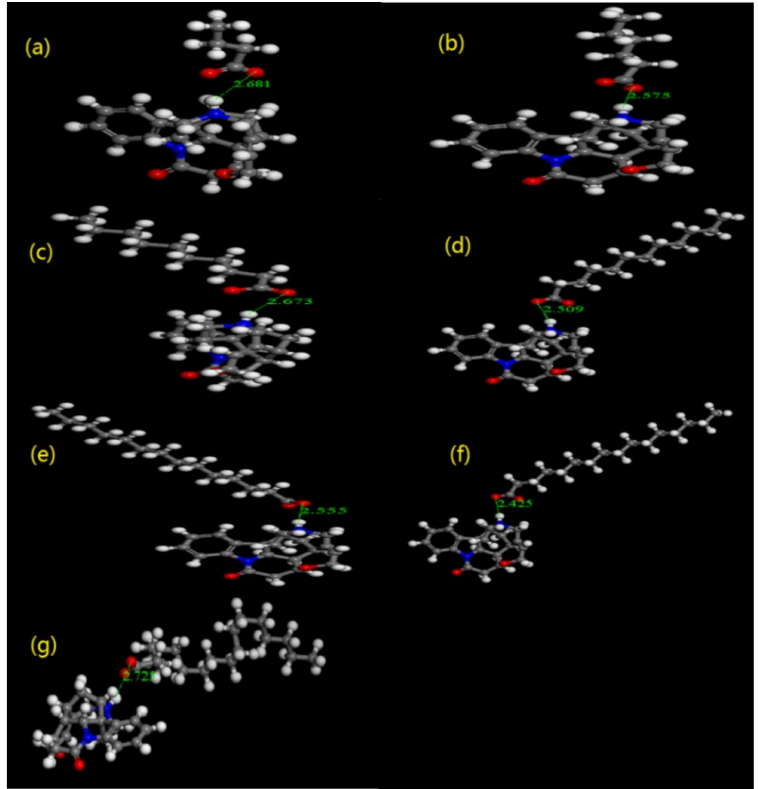
Figure 5. The molecular docking of Str ( a ) C 4 , ( b ) C 6, ( c ) C 10 , ( d ) C 12 , ( e ) C 14 , ( f ) C 16 , ( g ) C 18